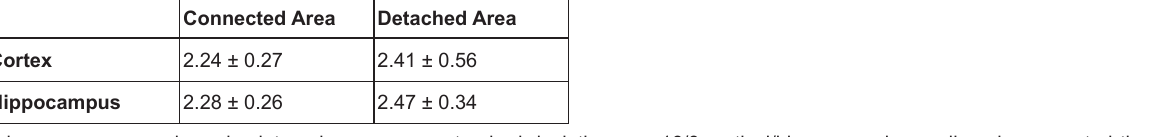
Table 1: Power law slopes of area distributions in the cortex and